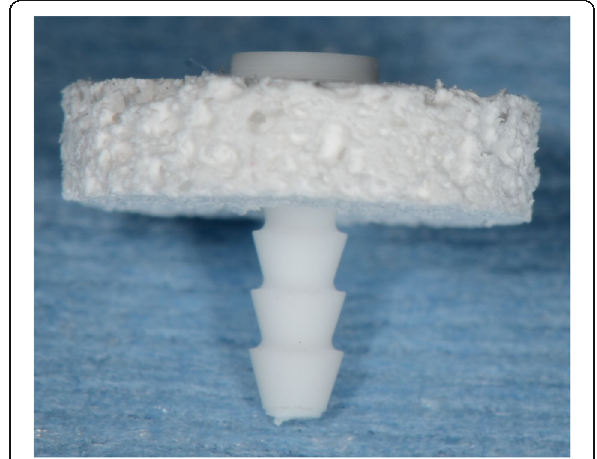
Fig. 1 Graft materials. Fixation pin u-HA/PLLA (1.5 mm in diameter × 6 mm in length). u-HA/PDLLA composite block (8 mm in diameter× 2 mm in